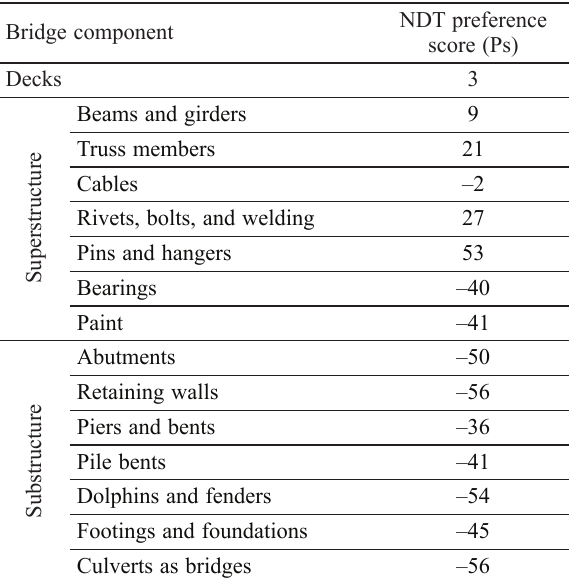
Table 5. NDT preference score for bridge components